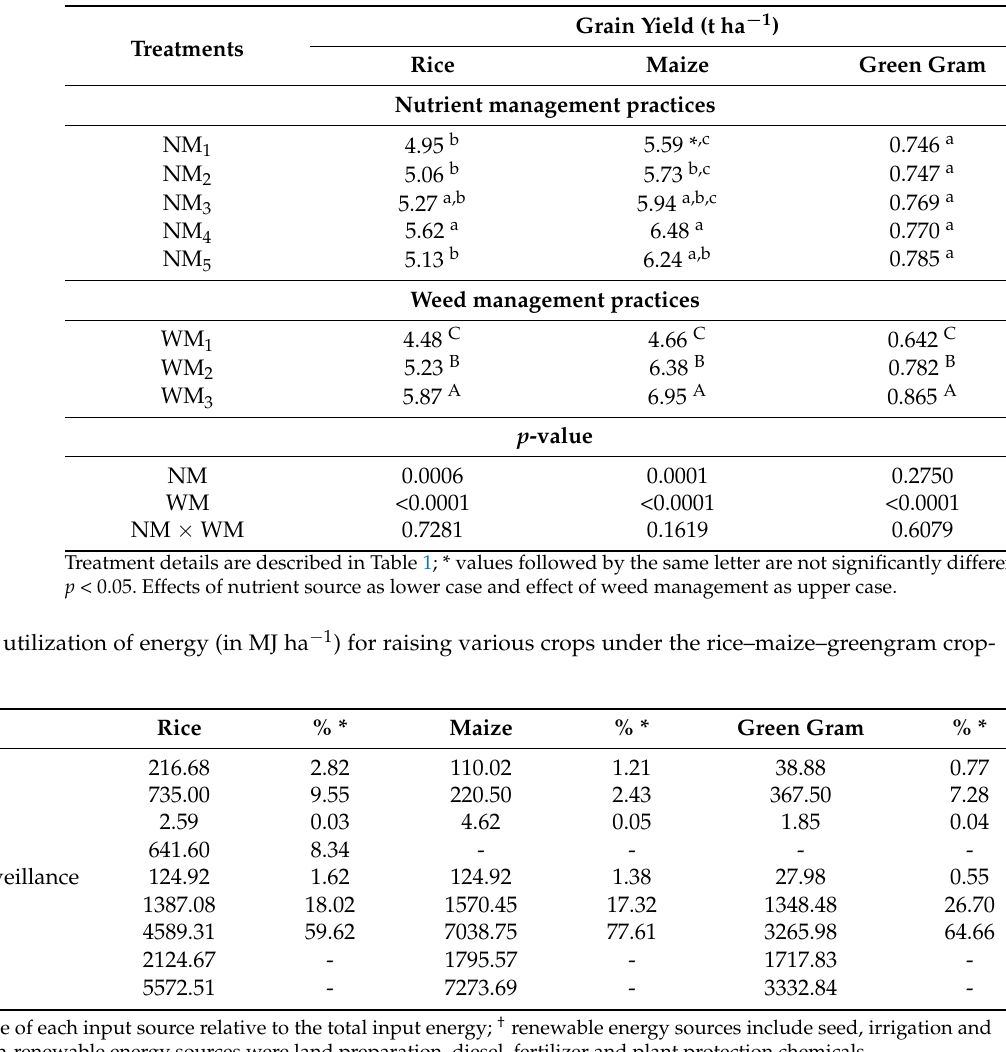
Table 3. Grain yield of different crops influenced by management practices (mean of two years) under the rice–maize–green gram cropping system.